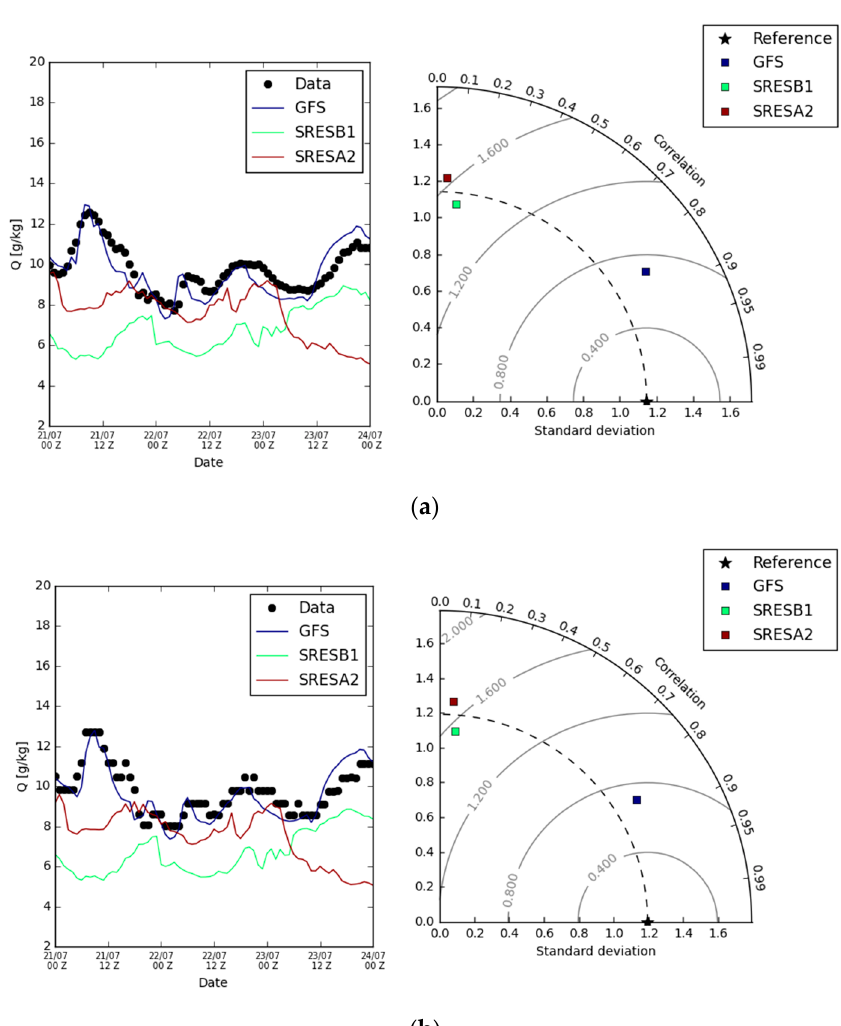
Figure 5. Evolution of specific humidity (left column) and Taylor diagram (right column) for ( a ) SIMEPAR and ( b ) Londrina Airport METAR data stations. Blue line is the simulation with GFS as input and boundary conditions, green line is the simulation with B1 scenario and red line is the simulation with A2 scenario. Both are output from CCSM3